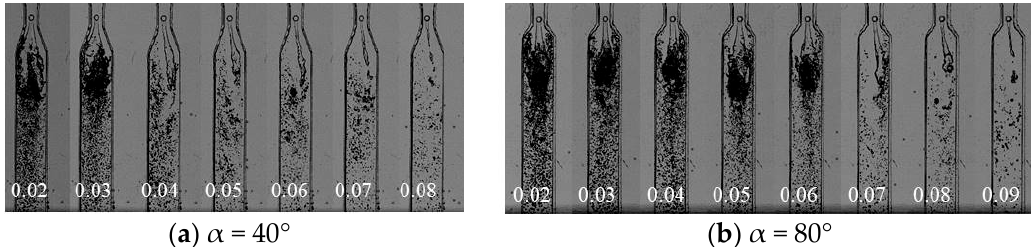
Figure 4. In the case of the bubbly flow, water–air two-phase flows according to the pressure ratio at the diverging angle of ( a ) α = 40°, ( b ) α = 80°.